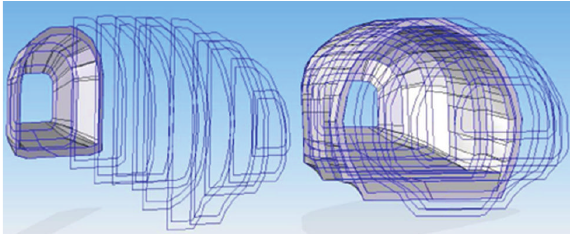
Figure 4: Design for the skull model.